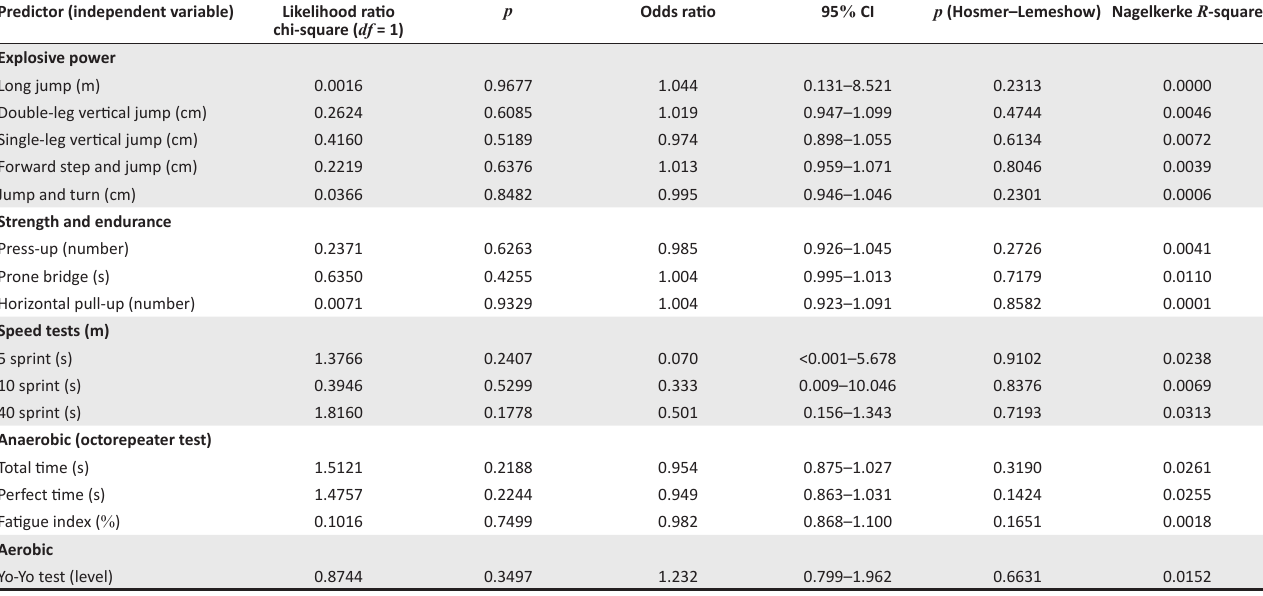
TABLE 4: Skill-related fitness as potential predictors of injury (univariate logistic regression). Predictor (independent variable)